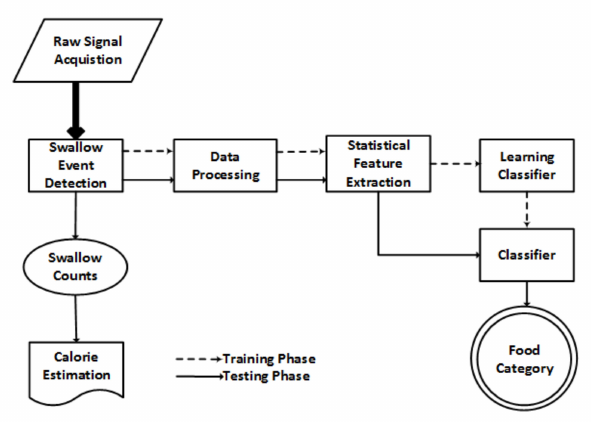
Figure 1. An overview of food intake monitoring